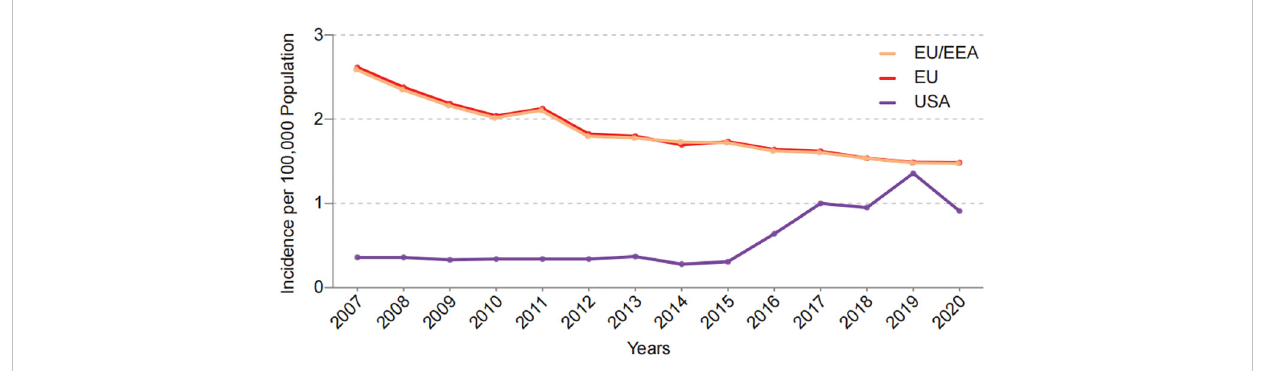
FIGURE 3 Incidence of Y.enterocolitica infections in EU/EEA, EU and USA per year from 2007 to 2020. Date come from European Centre for Disease Prevention and Control (ECDC) and Foodborne Diseases Active Surveillance Network (FoodNet).